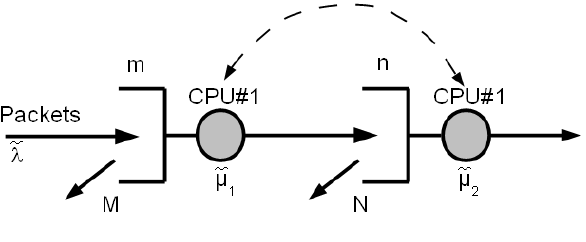
Figure 2. Queuing system representation for the case of one single